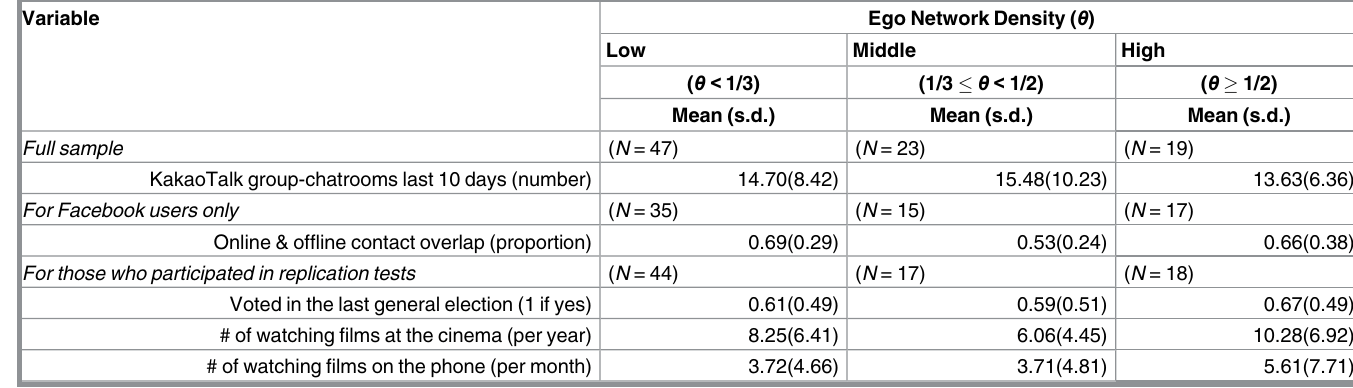
Table 3. Characteristics of the replication test sample.